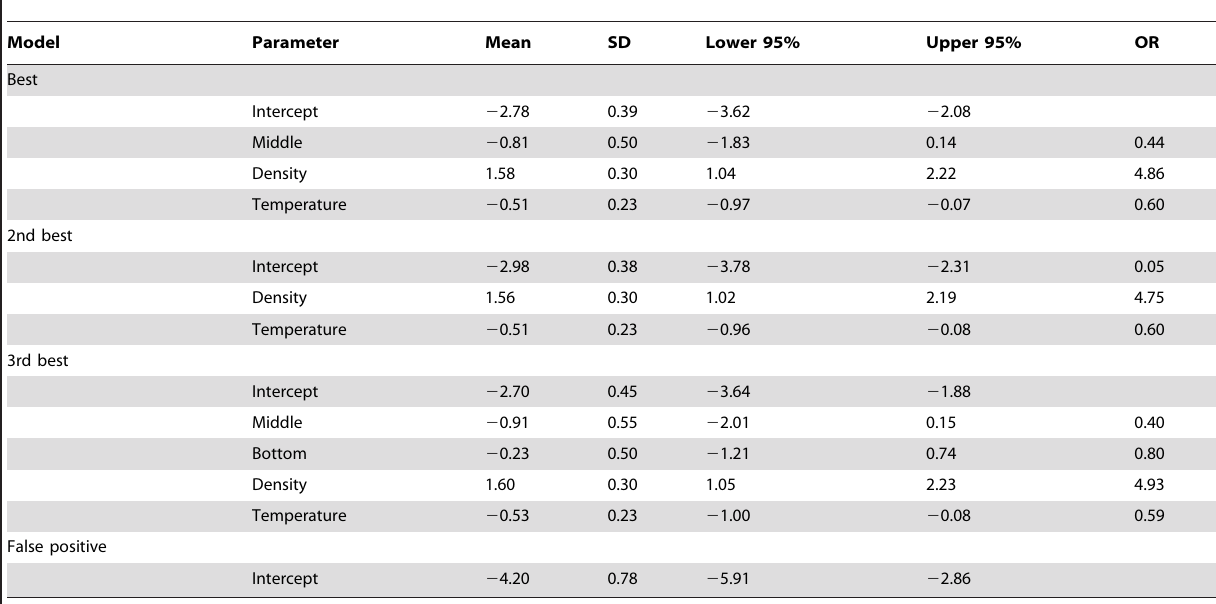
Table 3. Parameter estimates (Mean), standard deviations (SD), 95% credible intervals, and odds ratios (OR) from the confidence set of logistic regression models relating African jewelfish eDNA detections to pond- and sample-level factors.